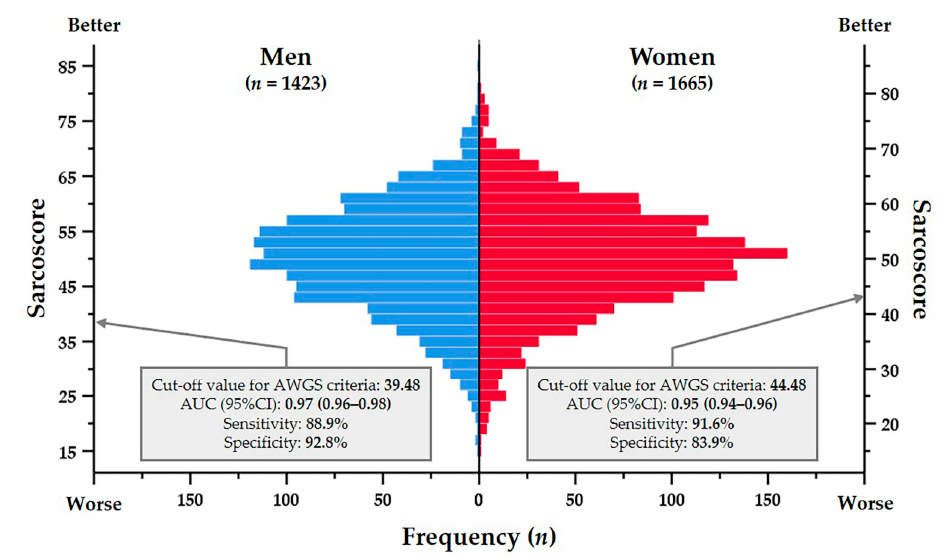
Figure 2. Distribution of sarcoscore on study population and its cut-off values for sarcopenia diagnosed by the Asian Working Group for Sarcopenia criteria. Note: AUC, area under the curve; AWGS, Asian Working Group for Sarcopenia; CI, confidence interval.